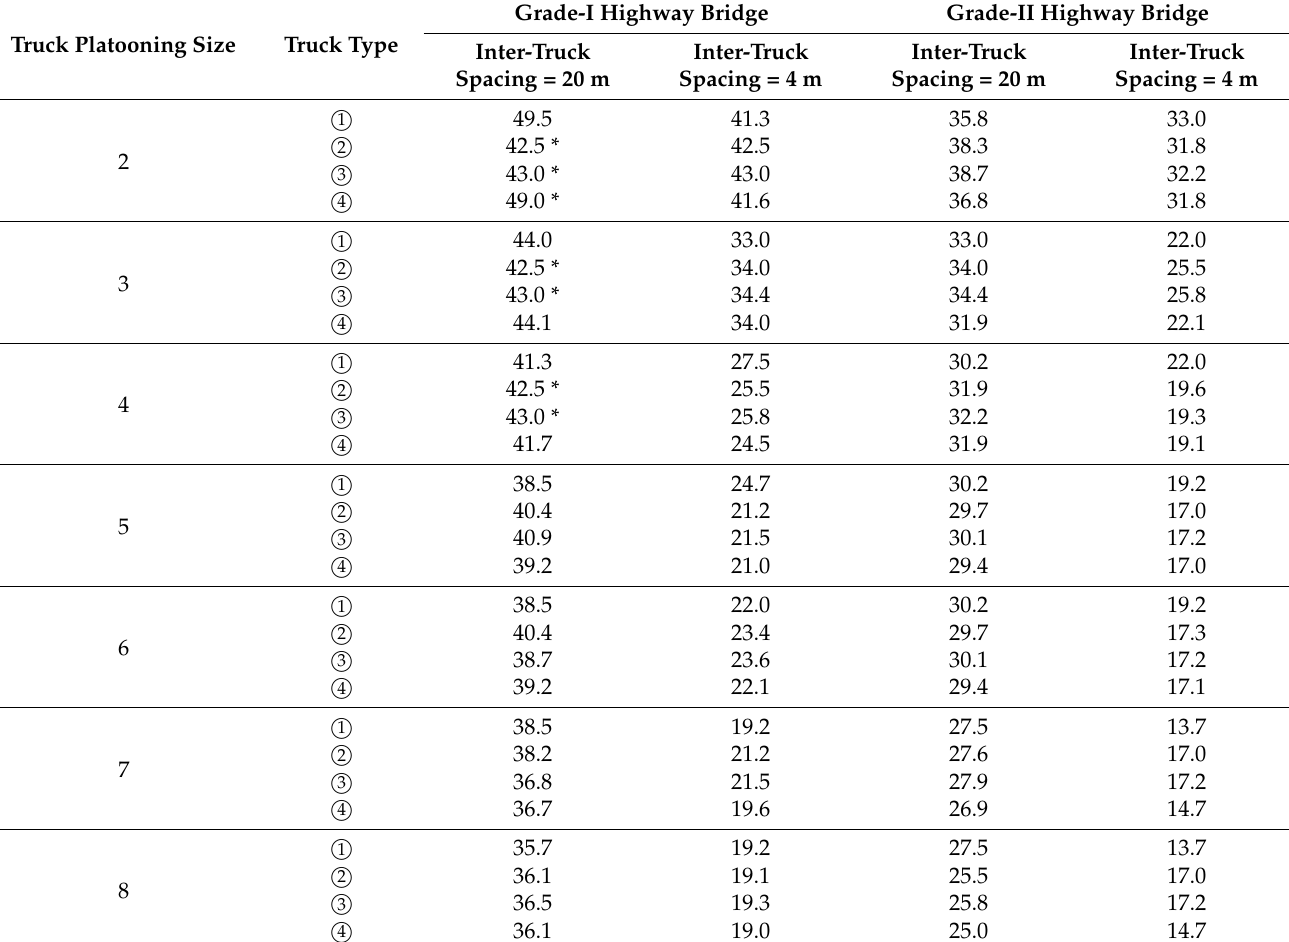
Table 3. Suggested upper mass limits (t) for platooning trucks crossing continuous bridges.